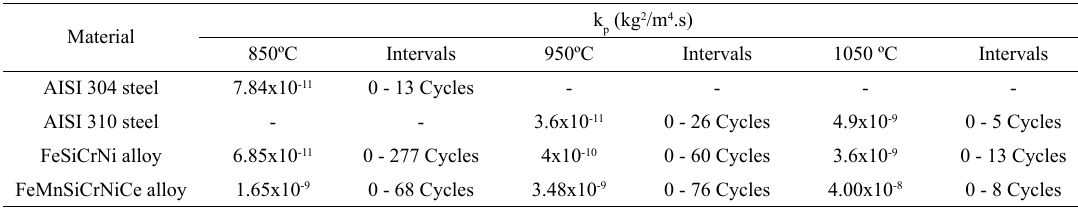
for the samples tested. p